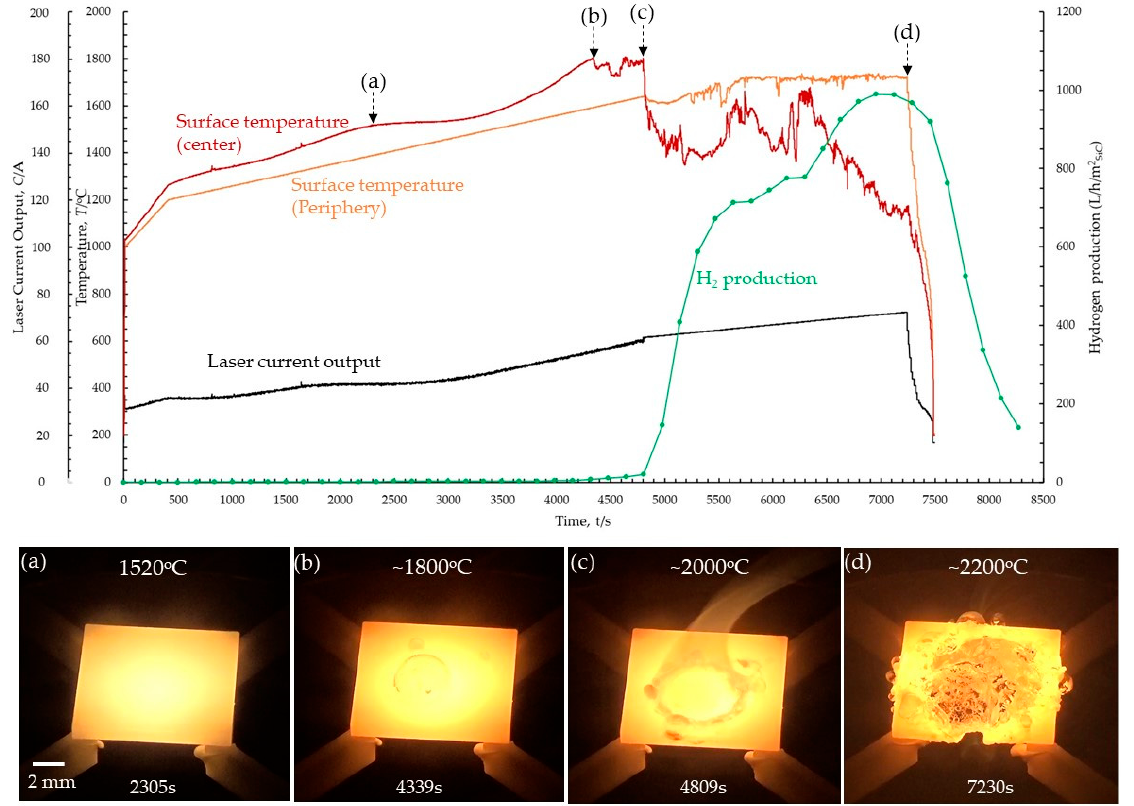
Figure 10. Experimental data (laser current, sample temperatures detected by pyrometers, hydrogen productions, and sample observation) of steam oxidation test for CVD-SiC/SiC composites using the laser heating facility (LAHF) [56].